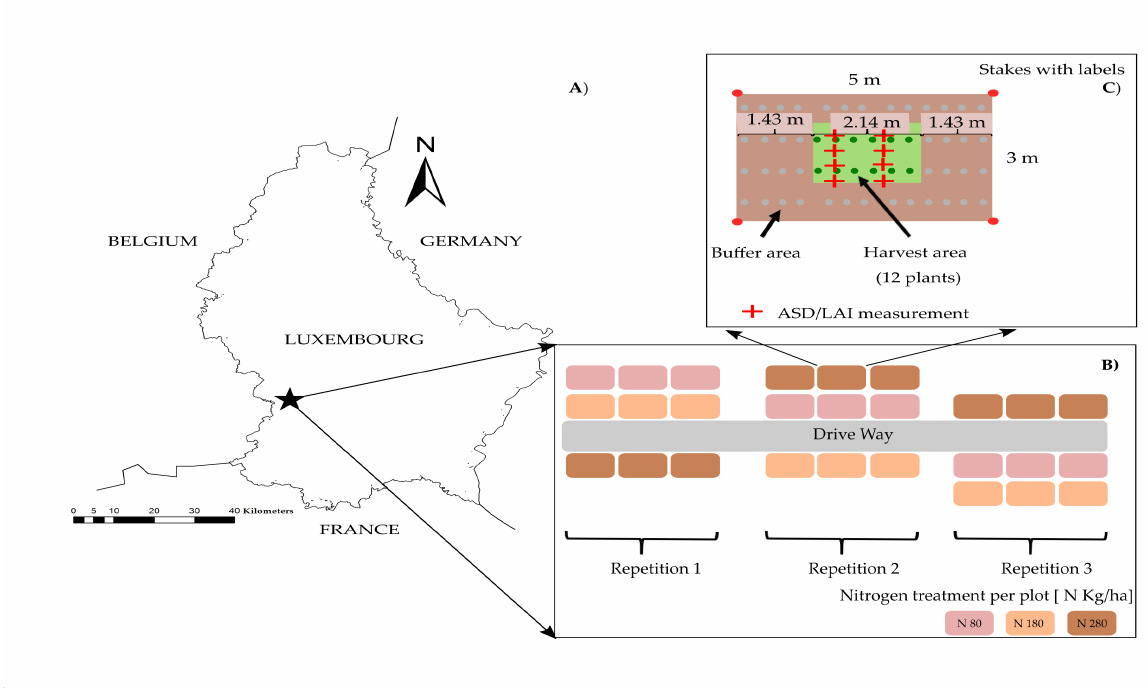
Figure 1. The layout of the experimental plots: ( A ) a map of the study area (left side) in which the star indicates the position of the study site; ( B ) the arrangement of the nitrogen fertilization experiment (the lower-right side); and ( C ) the plot design for in situ measurements (the upper